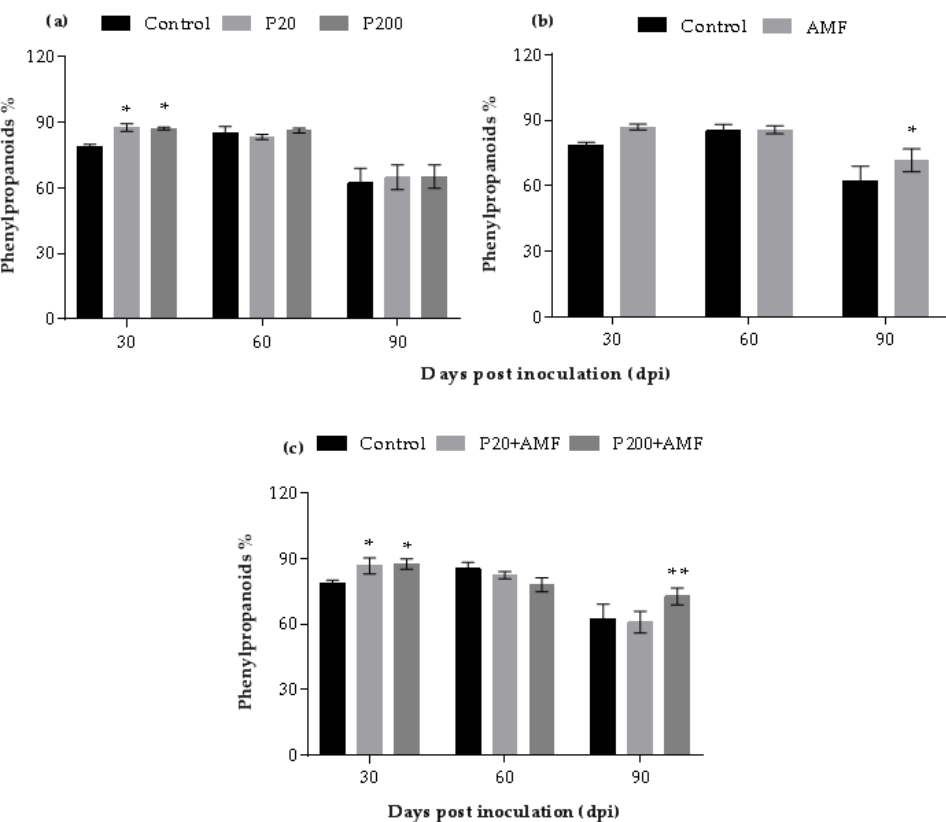
Figure 1. Variation of the phenylpropanoid content of Piper divaricatum : ( a ) plants treated with 20 and 200 mg of P · dm − 3 of soil (P20 and P200), ( b ) plants inoculated with AMFs (AMF), and ( c ) plants inoculated with AMFs and treated with 20 and 200 mg of P · dm − 3 of soil (P20 + AMF and P200 + AMF). Statistical difference according to Bonferroni test ( p < 0.05). Significance level: ** significant ( p < 0.01), * low significance ( p < 0.1) .